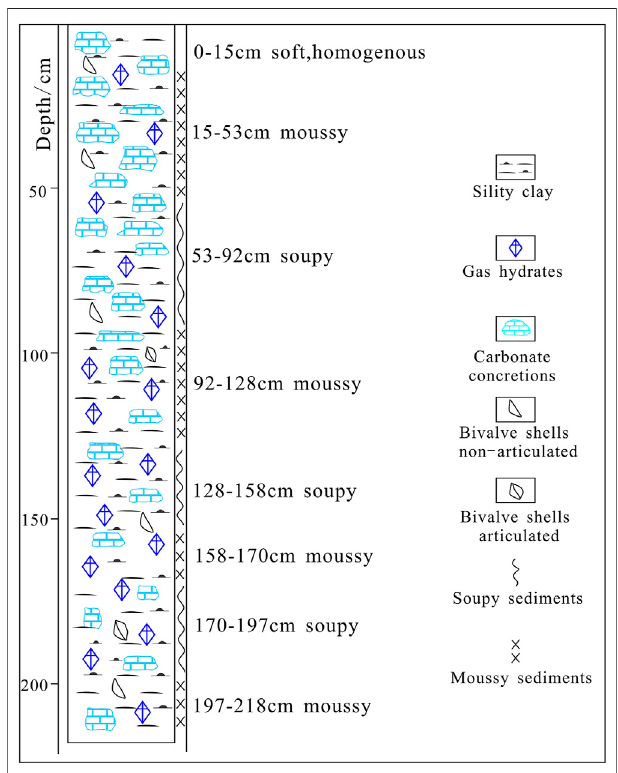
FIGURE 4 | Gravity core GC-11 from the Makran Accretionary Prism shows sporadically distributed hydrates in silty clay (Modi fi ed after Bohrmann and Ohling, 2008; Gong et al., 2017, site position shown in Figure 1